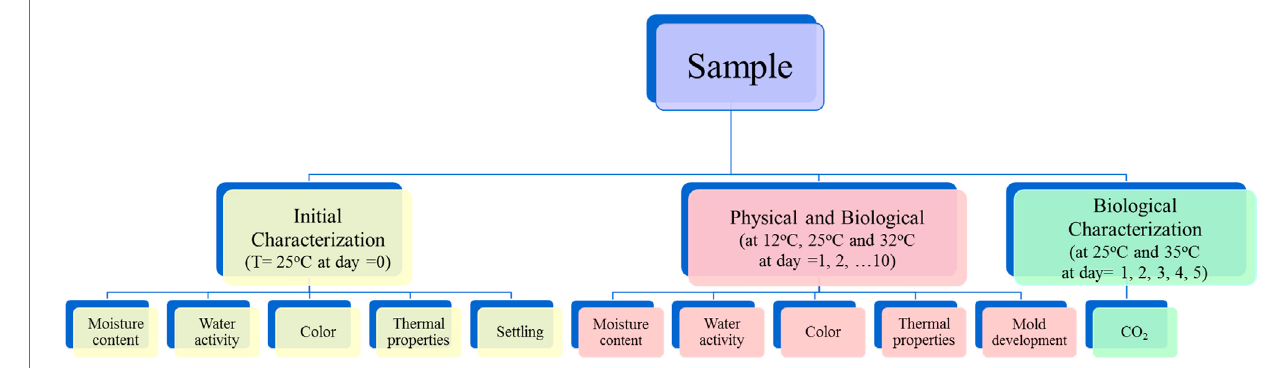
FIGURE 1 | Experimental approach used in this